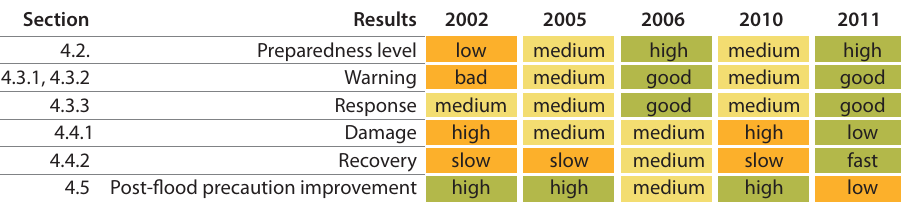
Figure 10. Qualitative summary of all